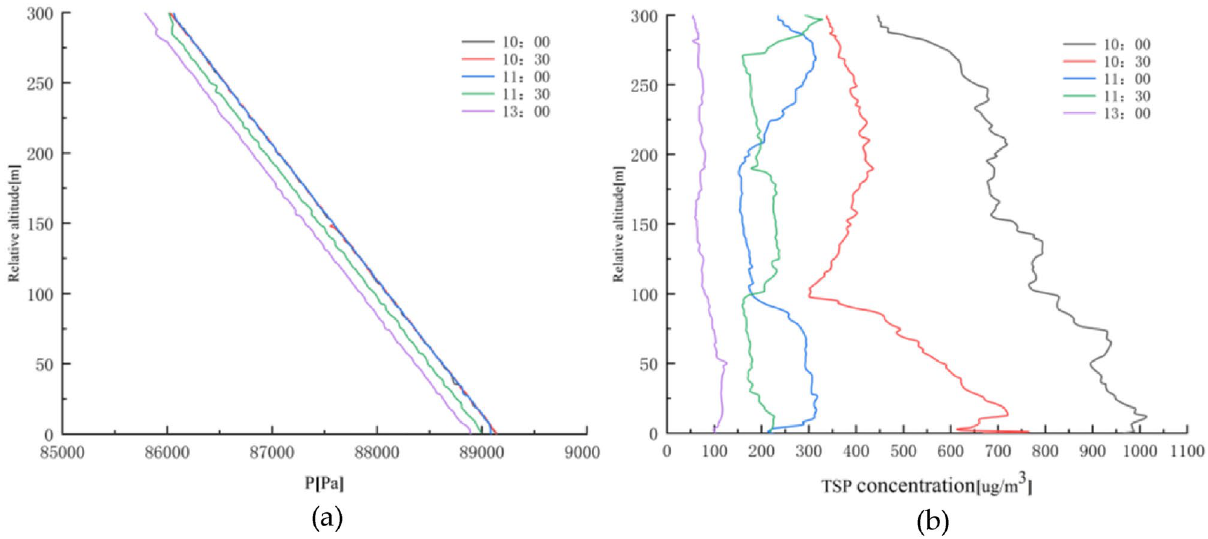
Figure 7. Relationship between air pressure, TSP concentration, and altitude in winter; ( a ) Air pressure versus altitude; ( b ) TSP concentration versus